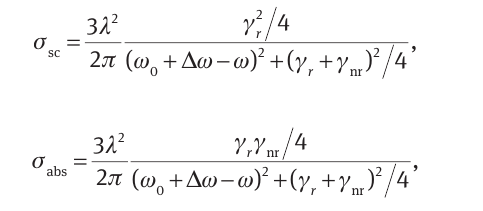
both the confinement effect (the second term in Eq. 5) and the Coulomb interaction (the third term in Eq. 5) deter- mine the bandgap in the spectrum of nanoparticles. The analogous dependencies for the QD bandgap vs. QD size were observed for PbSe and ZnO nanoparti- cles [42–44]. Thus, for variety of QDs, quantum confine- ment provides wide spectral tunability within a single QD material.